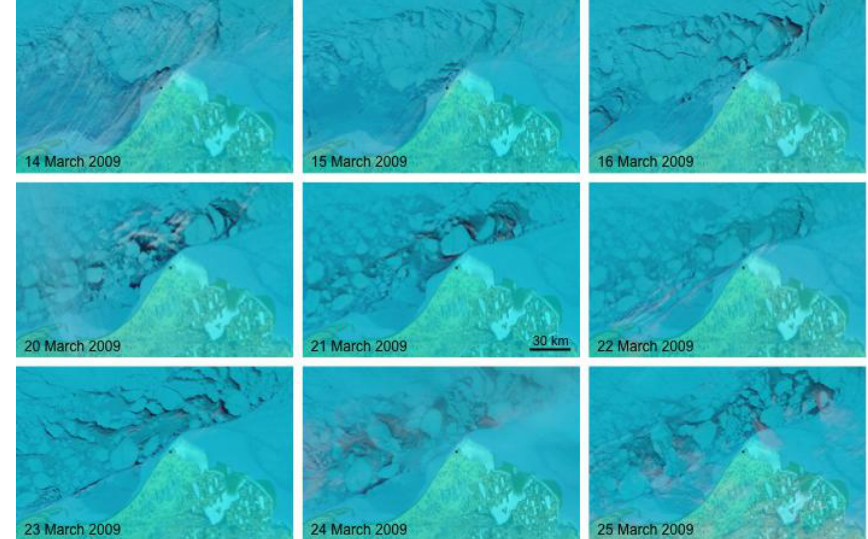
The black dot indicates the sampling location. The colours represent as follows: very light blue (lake ice or ice lagoon); light blue (first-year or older sea ice); darker blue (thinner and younger sea ice) and black (open water or thin new/nilas ice)